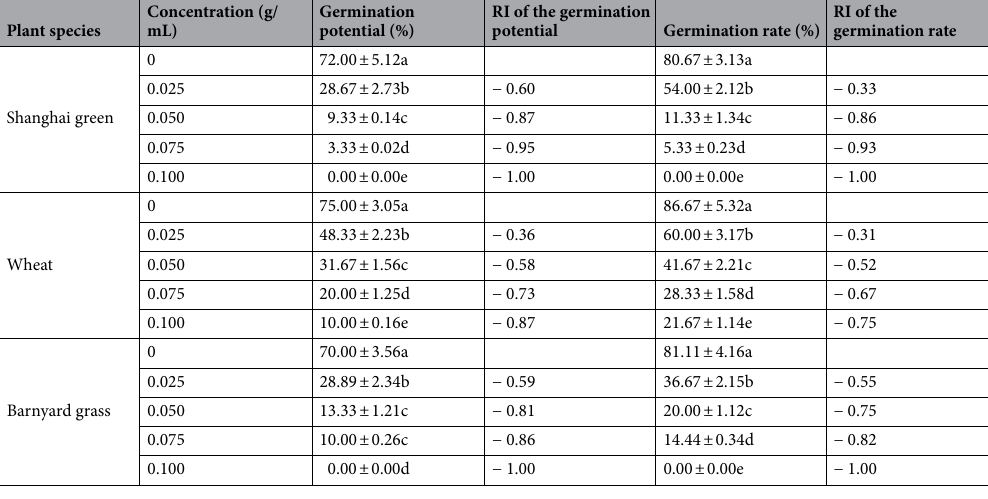
Table 1. Effects of the water extract from leaves of Flaveria bidentis on the seed germination potential and germination rate of three plants. Data are shown as the mean ± standard deviation. Different letters in the same column for each treatment indicate significant differences at the P < 0.05 level, while the same letter indicates no significant difference at the P < 0.05